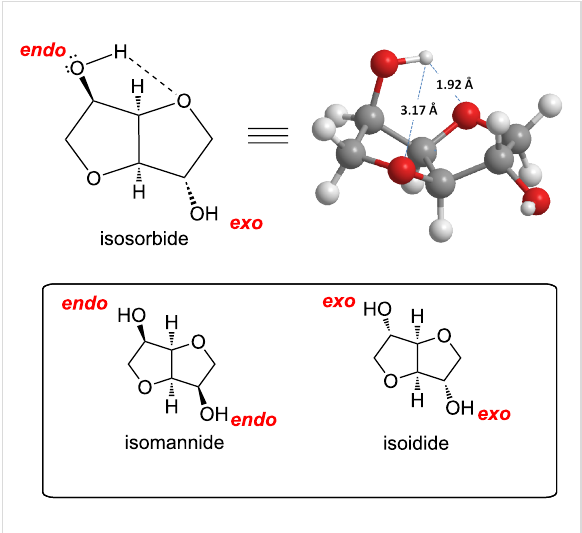
Figure 3: Chemical structure of isosorbide and its epimers isoman- nide and isoidide.